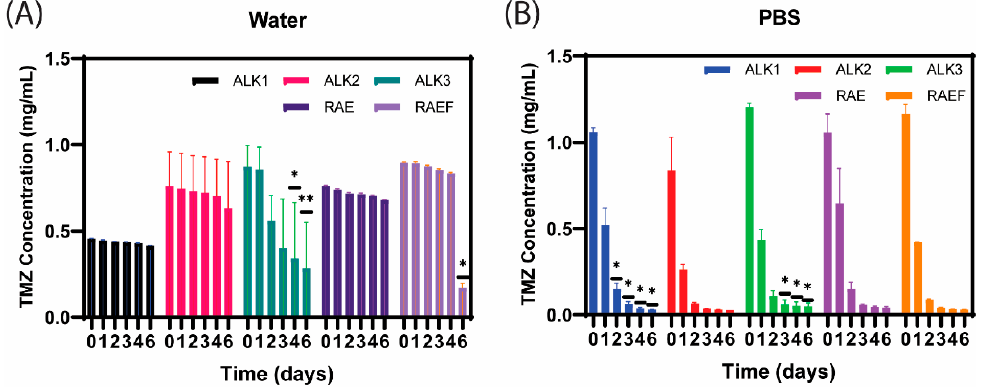
Figure 4. Peptides were prepared and loaded with TMZ using film dehydration and resuspended in either water ( A ) or PBS ( B ). TMZ concentration was measured from 0–6 days using UV–vis spectrophotometry. Data are presented as mean ± SEM (N = 3), where * p < 0.05 and ** p < 0.01 compared to time 0 (one ‐ way ANOVA with Dunnett’s multiple comparisons test).